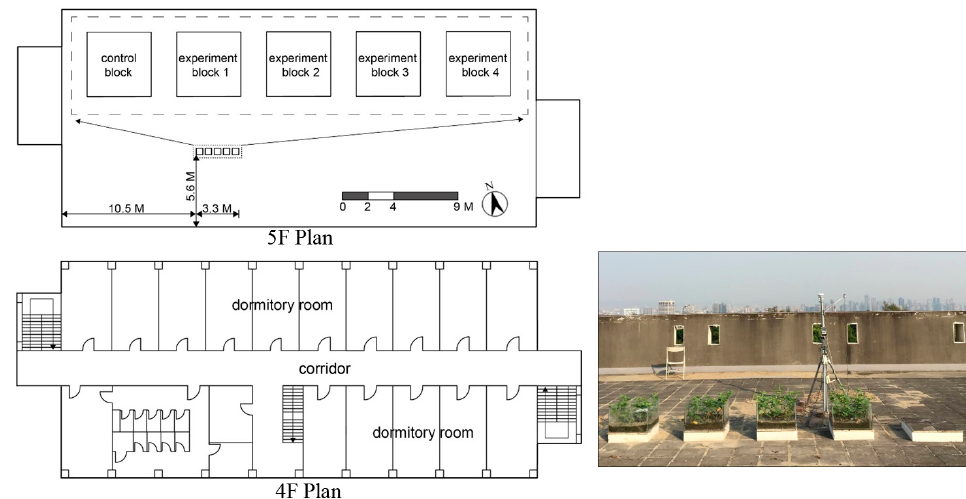
Figure 2. Floor plans of the fourth ( lower left ) and fifth ( upper left ) floors. Five blocks on the fifth floor served as experimental blocks ( upper left ). Experiment site and experimental setup ( right ).